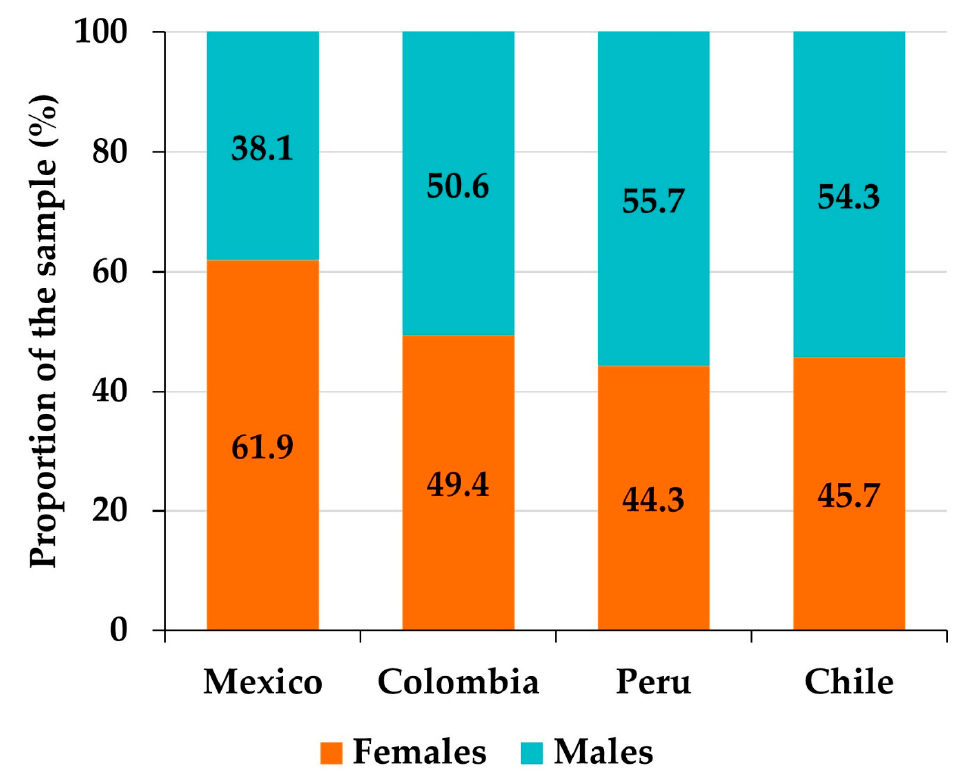
Figure 1. Distribution of participants by country of origin and gender.